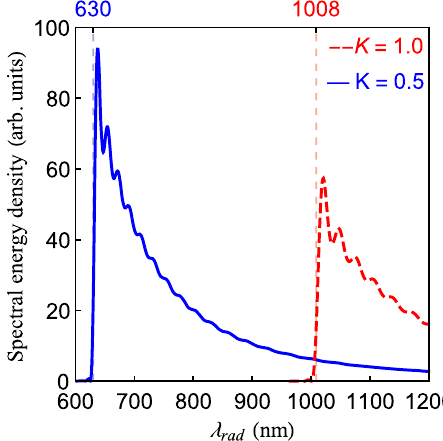
FIG. 8. Circular polarization: Far-field spectral energy density (energy/wavelength) for two different values of K . The electron energy is 60 MeV while λ u ¼ 1 . 39